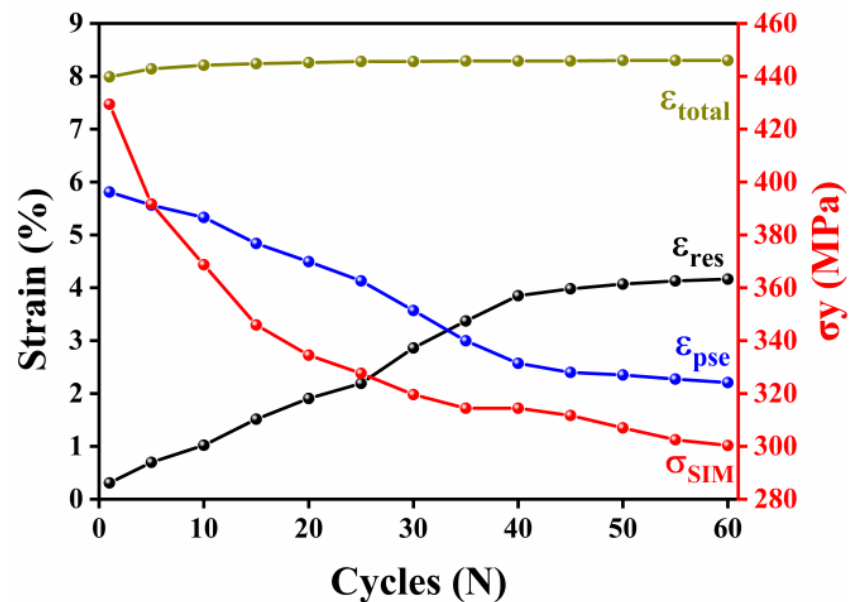
Figure 6. Evolution of critical stress to trigger stress-induced martensitic transformation ( σ SIM ), total strain ( ε total ), residual strain ( ε res ), and pseudoelastic strain ( ε pse ) during 60 cycles of